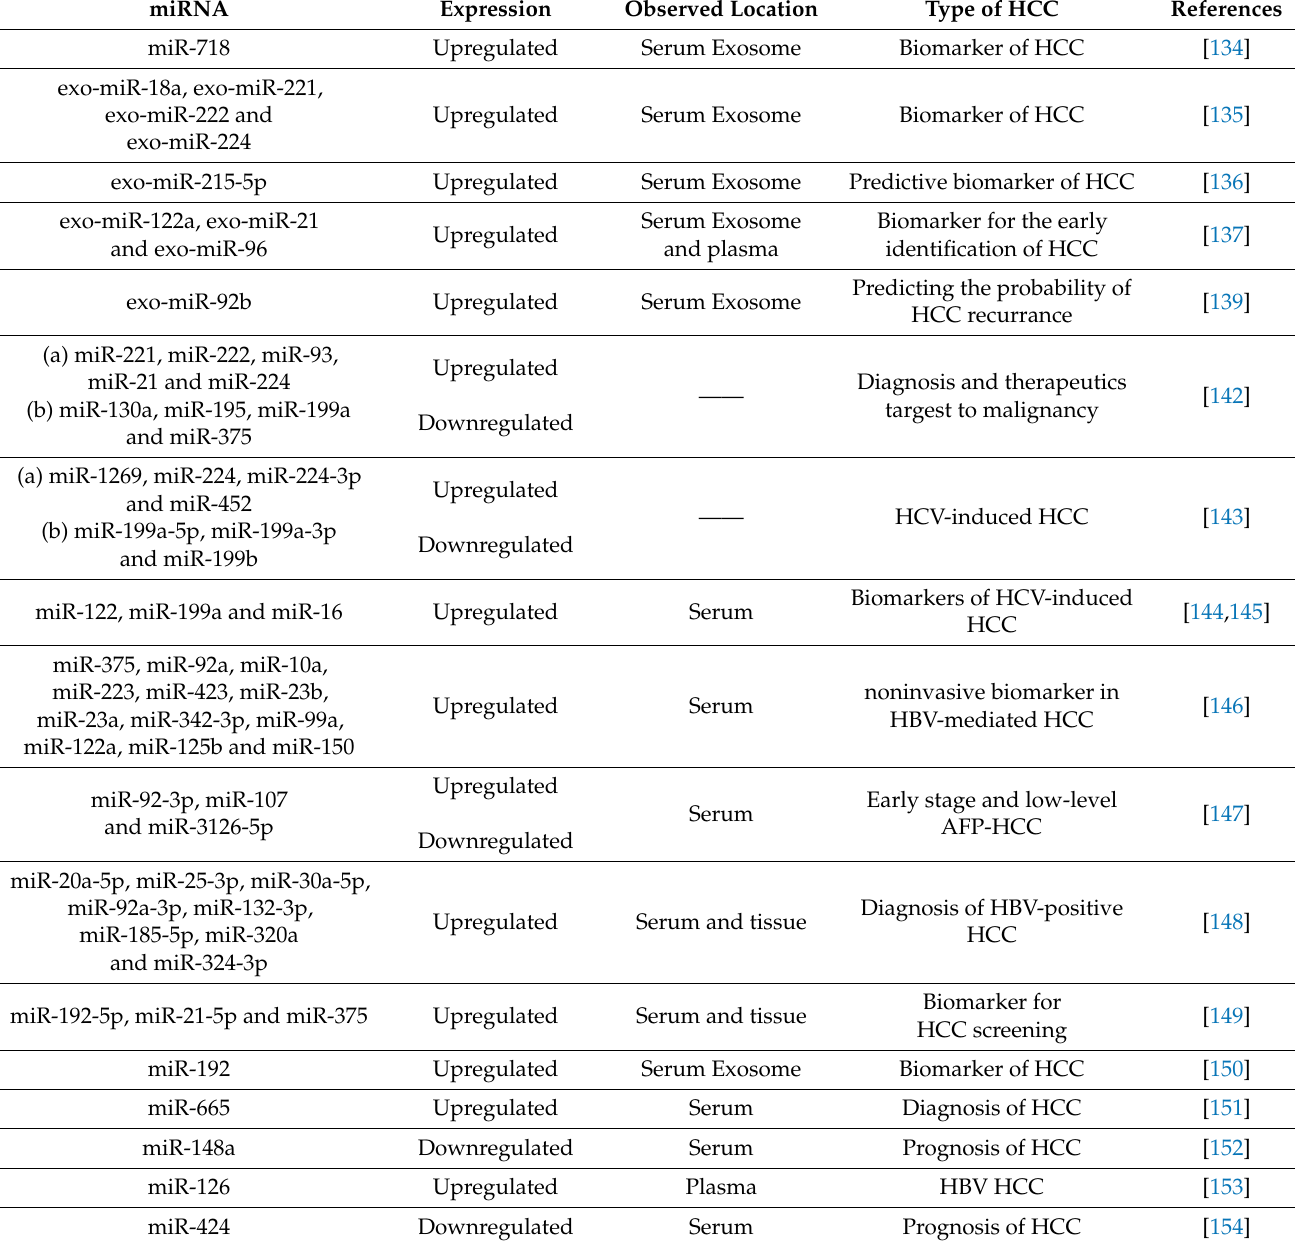
Table 2. Diagnostic and prognostic miRs in